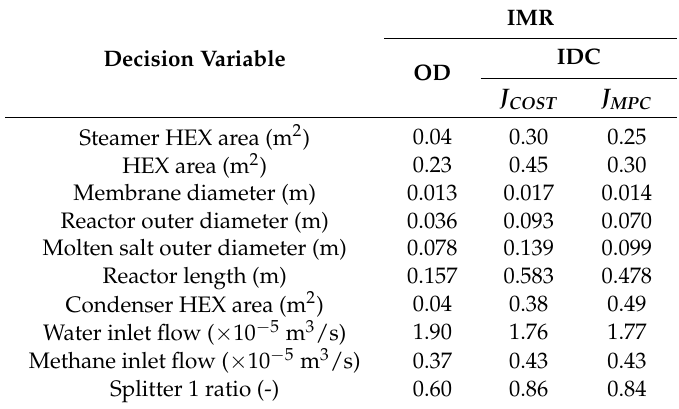
Table 3. Decision variables for the IMR flowsheet. Comparison between optimal values calculated by multi-objective optimization and integrated design and control